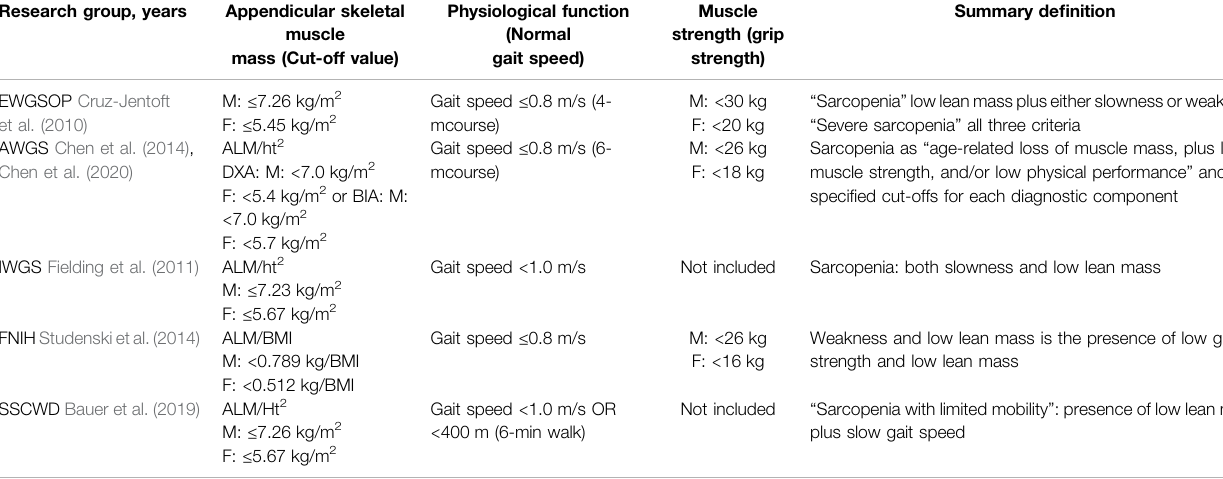
TABLE 1 | De fi nitions of sarcopenia of different research groups. Research group,